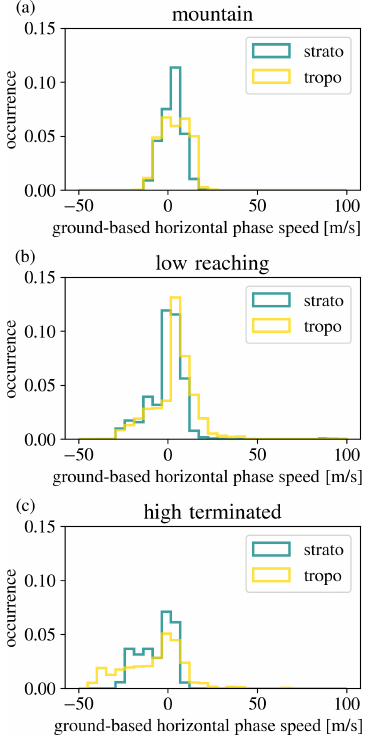
Figure 7. The phase speed of the gravity waves in the direction of the wave vector and relative to the ground at (blue) the observation altitude (25km) and at (yellow) the ray termination for the three ray termination classes,